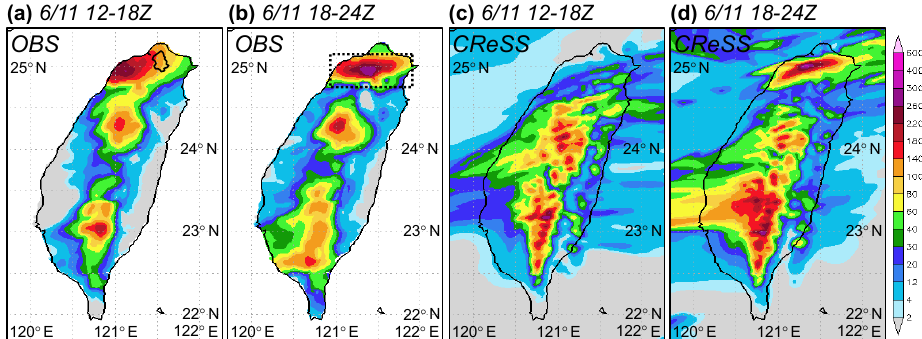
Figure 5. Distribution of observed 6h accumulated rainfall (mm, color, scale to the right) over Taiwan during (a) 12:00–18:00UTC and (b) 18:00–24:00UTC on 11 June 2012. The Taipei City boundary is depicted in panel (a) , and the dotted box in panel (b) shows the region used in Fig. 8 for rainfall average. (c, d) As in panels (a, b) , but showing model-simulated rainfall over Taiwan and the surrounding